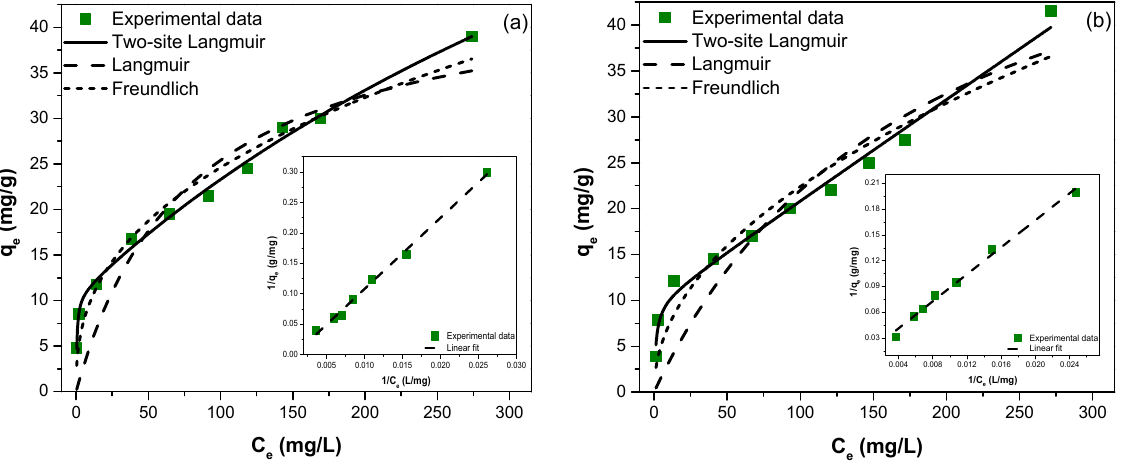
Figure 8. Adsorption isotherms, nonlinear fitting models of two-site Langmuir, Langmuir, and Freundlich isotherms, and linear fitting model of two-site Langmuir isotherm (insert) for fluoride removal ( a ) ZGluGO and ( b ) ZAspGO at 25 °C.